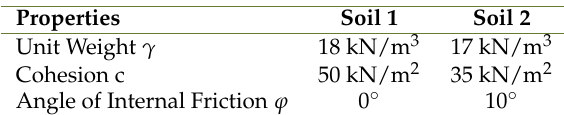
Table 1. Properties of Soils